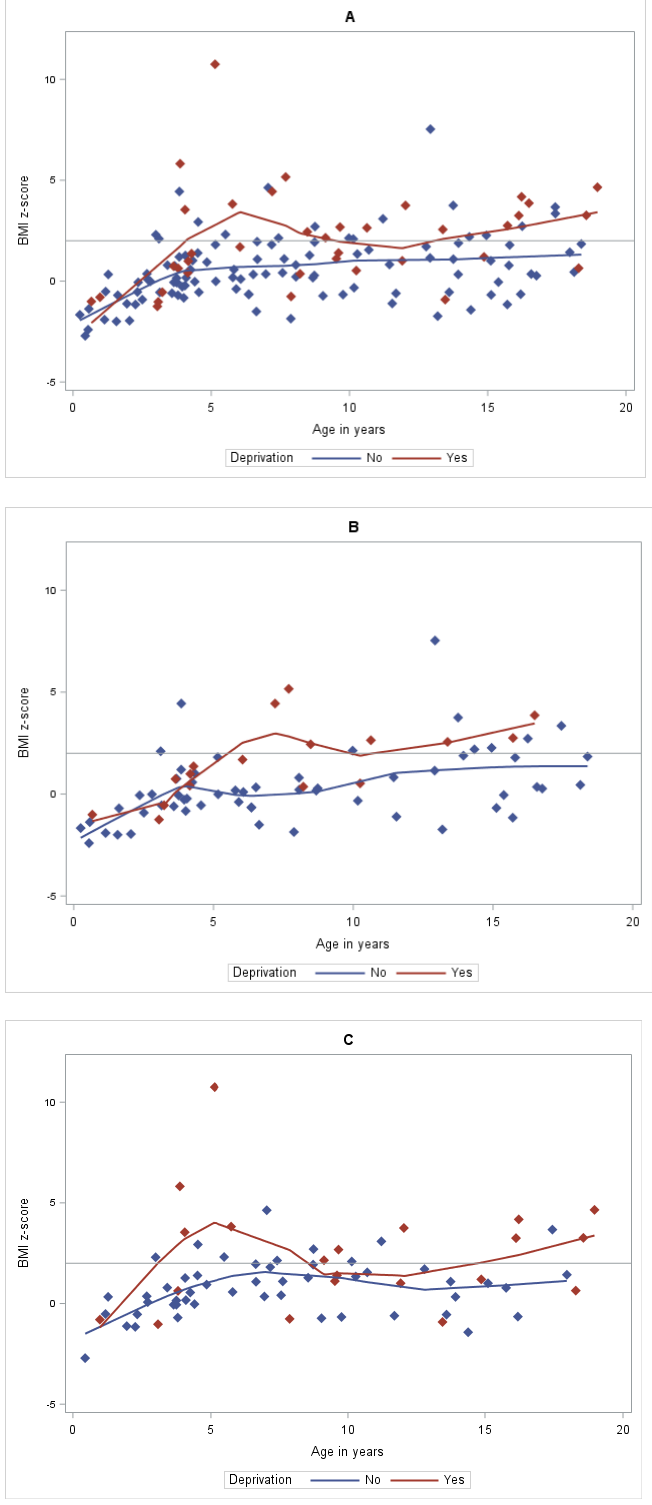
Figure 2. Scatter plot and Loess curves of BMI by age in years of children and deprivation ( A ) in the 147 children with PWS; ( B ) in the 75 boys with PWS; ( C ) in the 72 girls with PWS. In blue, non-deprived patients, and in red, deprived